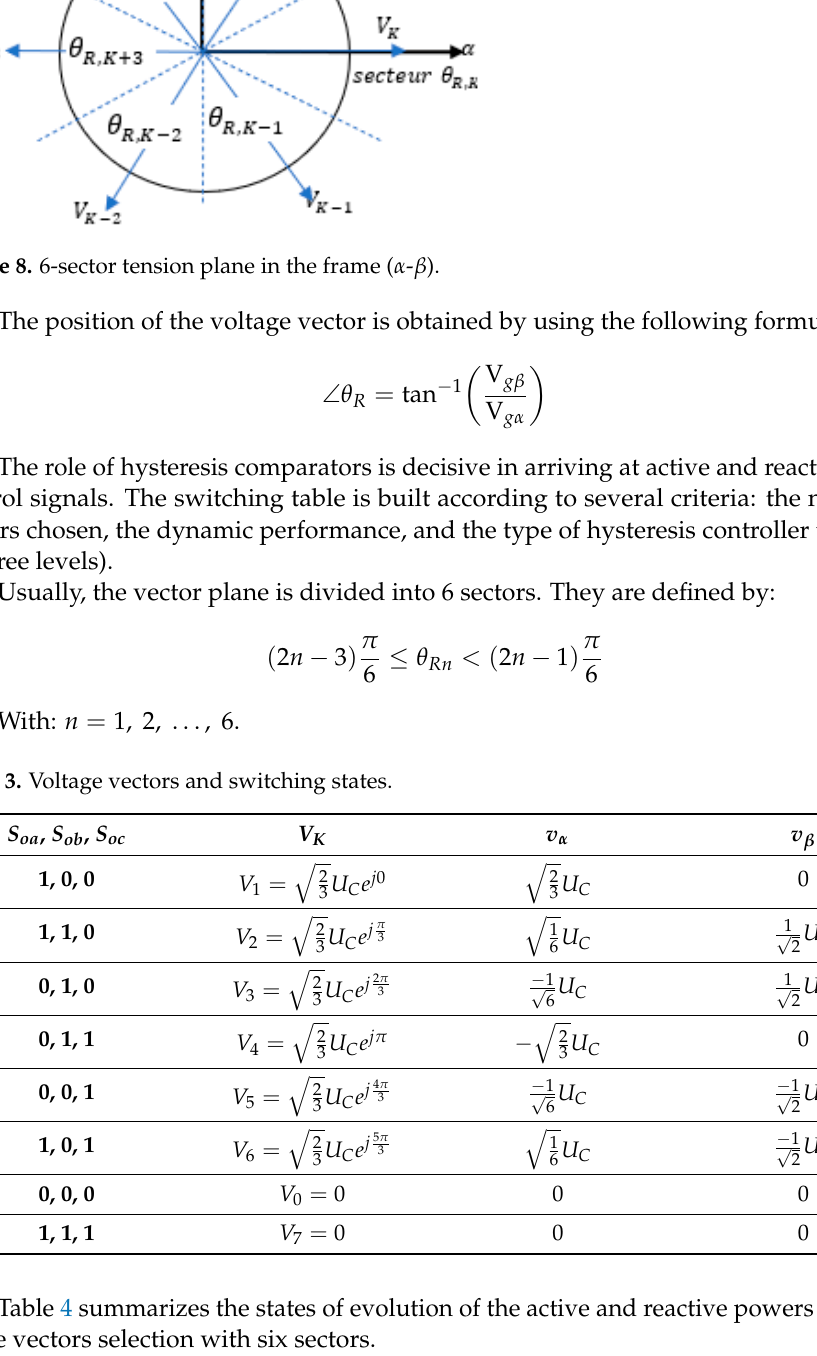
Table 3. Voltage vectors and switching states.